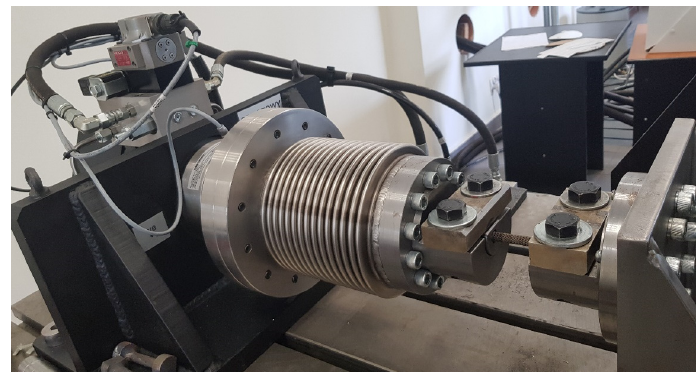
Figure 7. Instron 8802 torsional strength test rig.